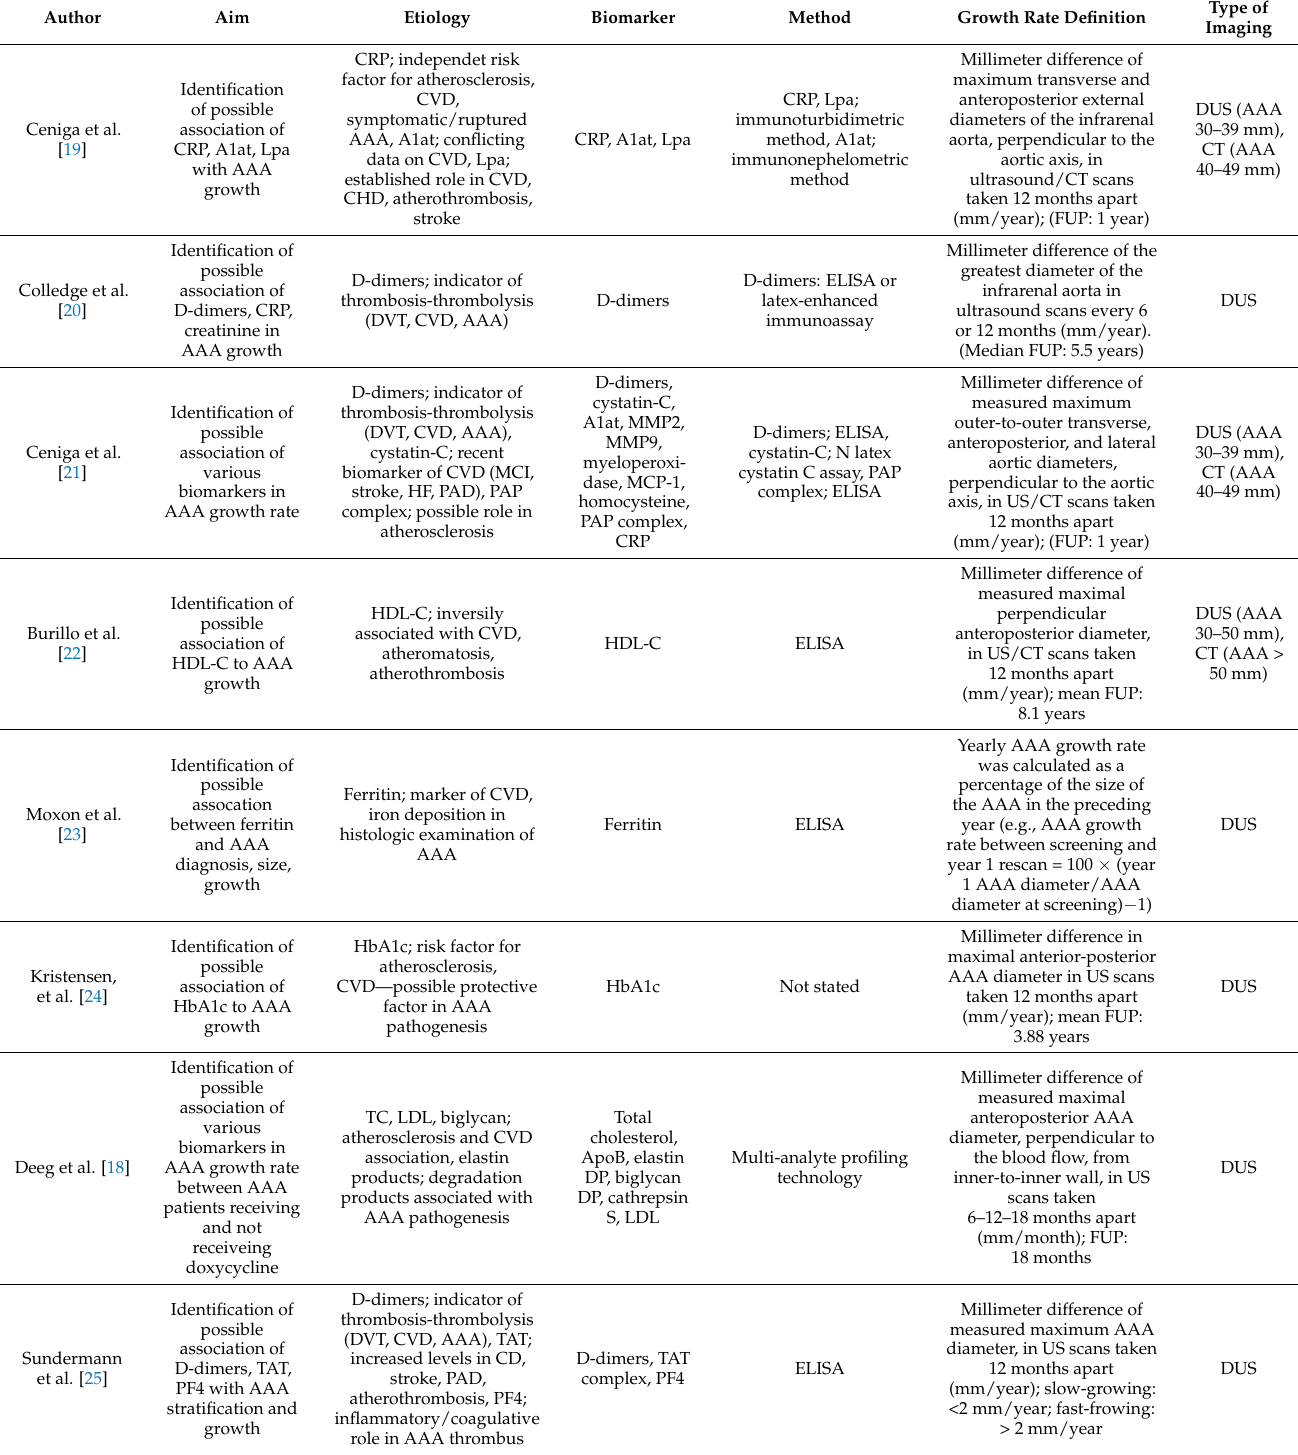
Table 3. Specific characteristics of studies on circulating clinical